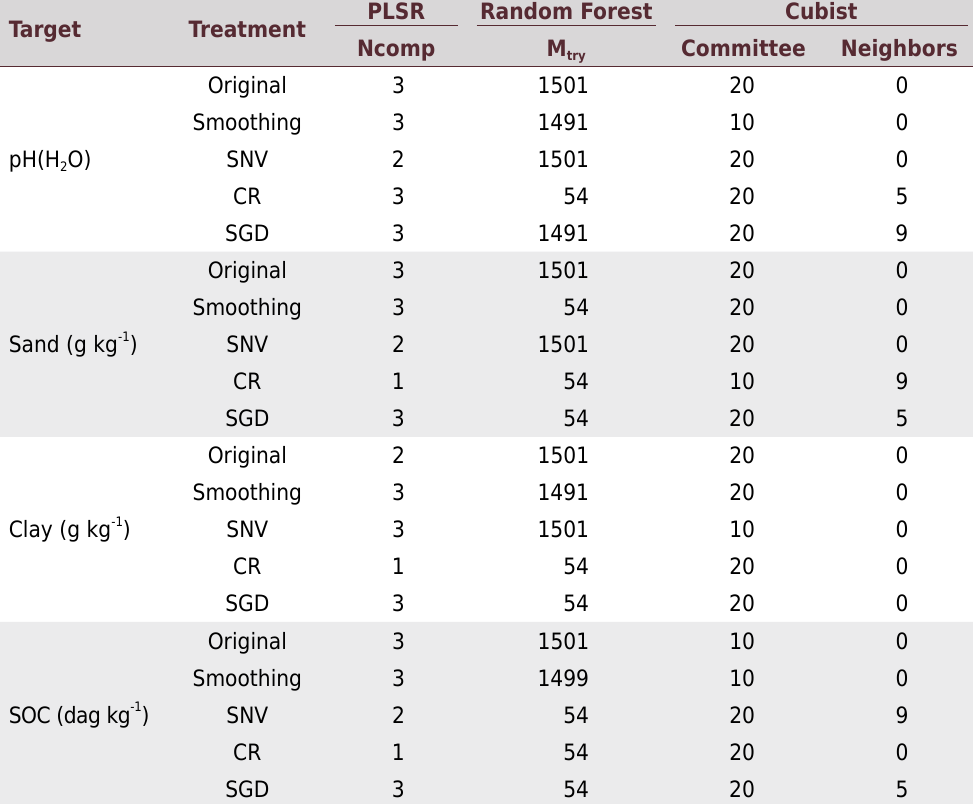
Table 1. Internal model parameterization of the three predictive methods analyzed for pH(H 2 O), sand, clay, and organic carbon using the R package